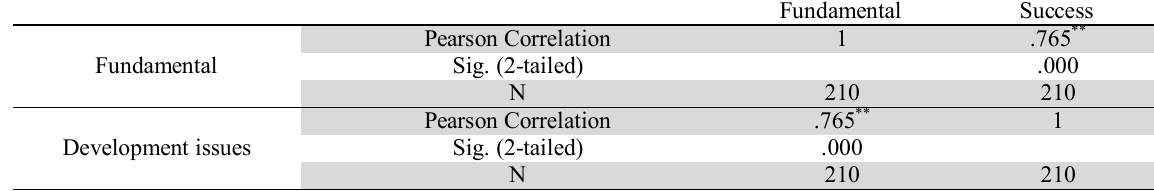
The summary of implementation of Pearson correlation ratio for the second hypothesis